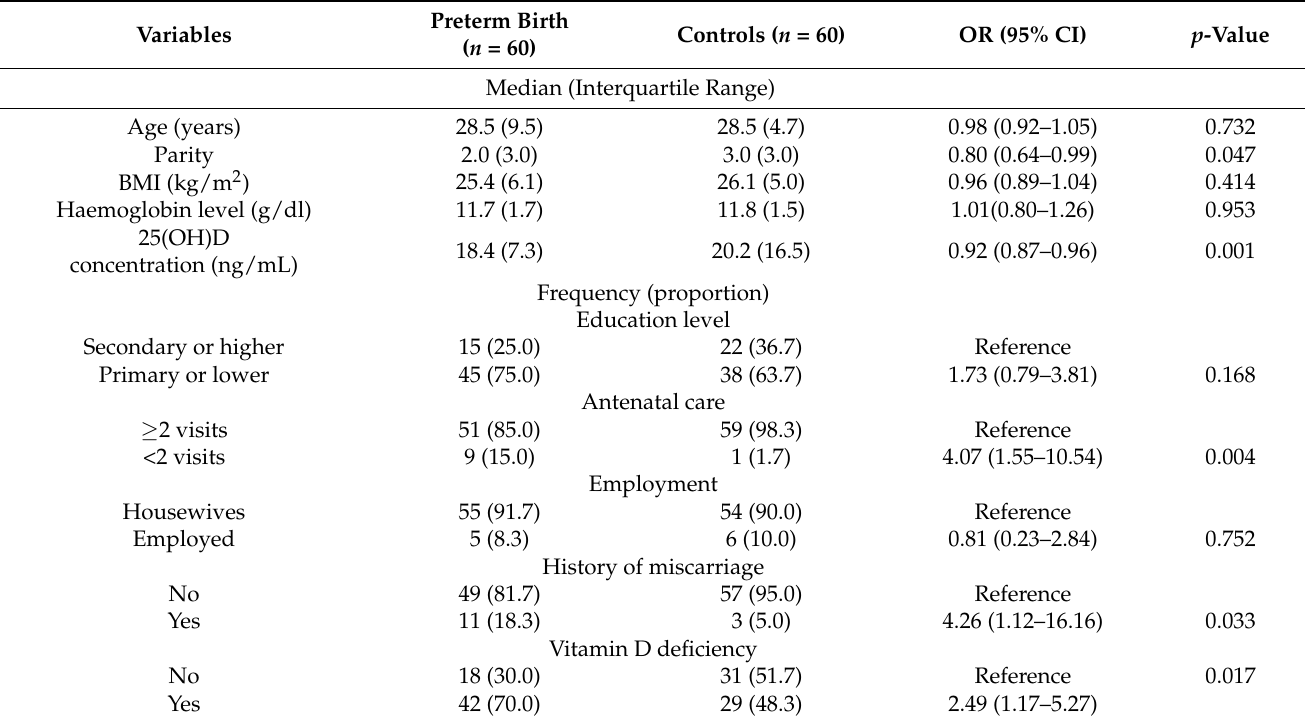
Table 1. Univariate and bivariate analysis of sociodemographic and clinical variables in women with preterm birth and the